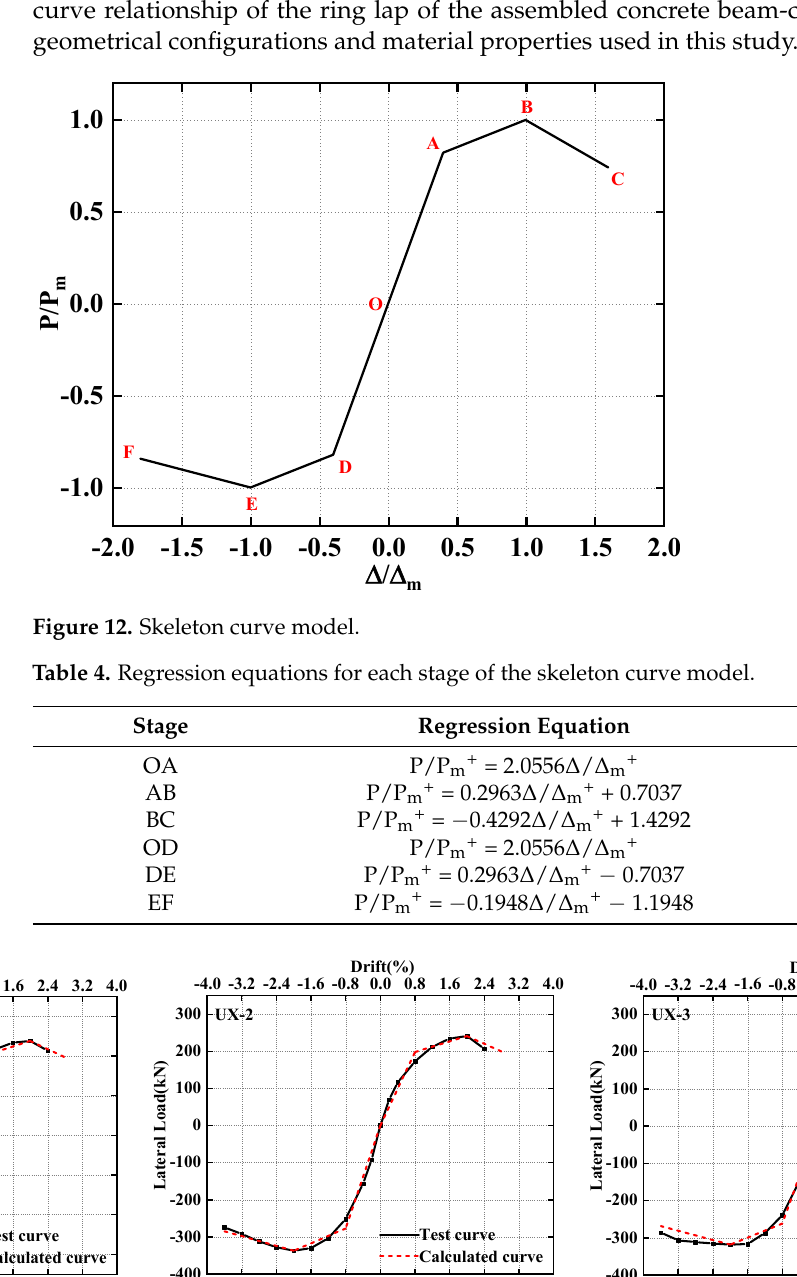
Calculated curve